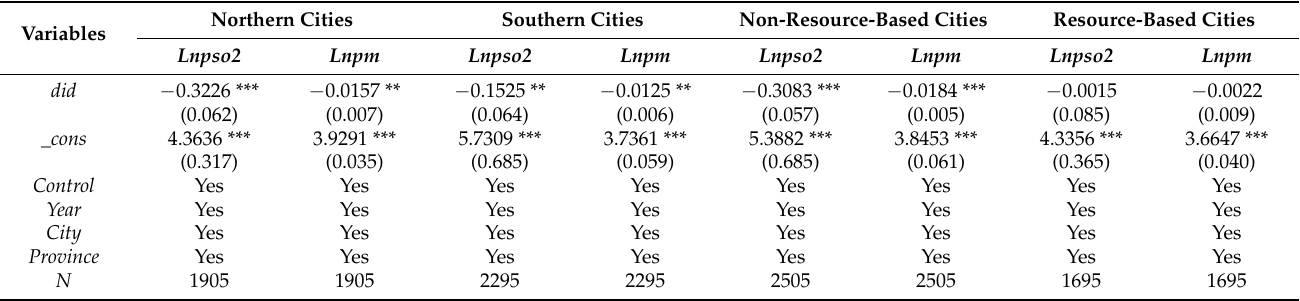
Table 7. Analysis of